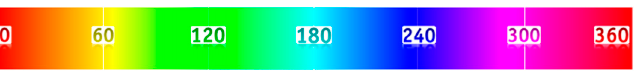
Table 1. Comparison of system storage space. where d is the depth value, disp is the disparity value, d min and d max are the shortest and longest depth values, which are chosen manually, and finally, p r , p g , and p b are the colorized pixels.